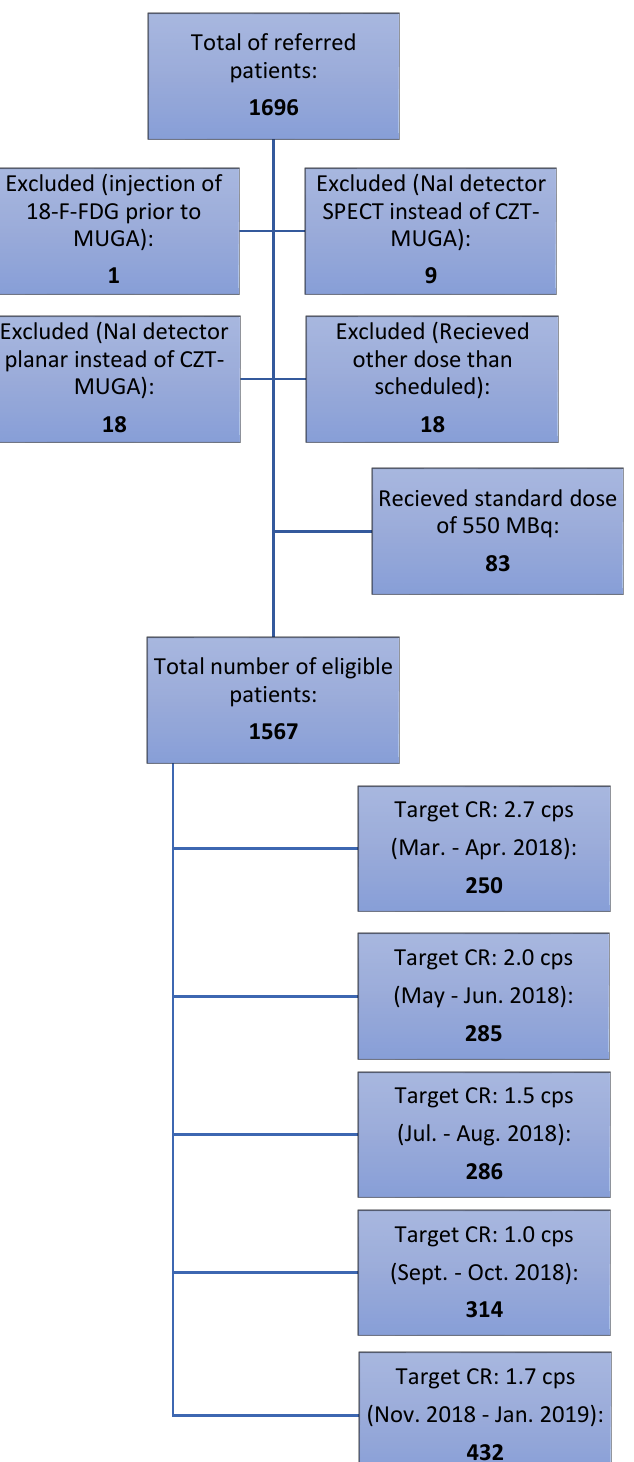
Figure 1. Flow chart of patients in and excluded from the